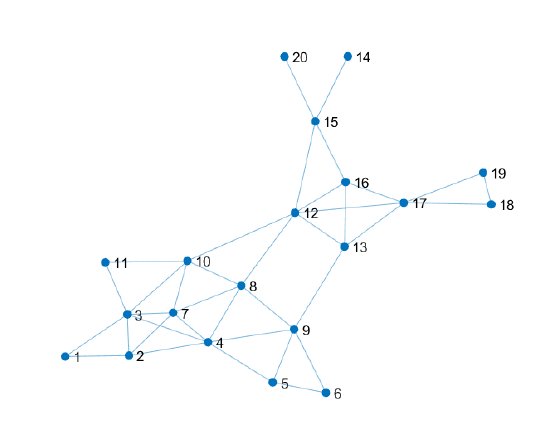
Figure 1. Network of 20 sensors for measuring the noisy positions of the